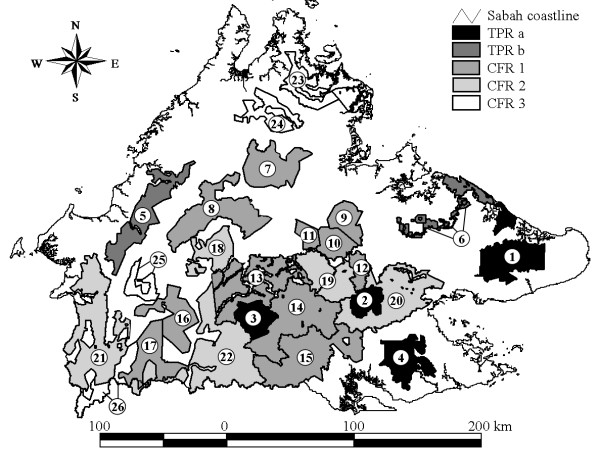
Protected areas in Sabah, ranked according to their protection status and importance for clouded leopard conservation. Names of reserves are shown in Table 1. TPR a = Totally protected reserve with a stable clouded leopard population, TPR b = Fragmented TPR, CFR 1 = Commercial forest reserve with clouded leopards present, CFR 2 = CFR with unknown clouded leopard status, CFR 3 = CFR with clouded leopards absent.